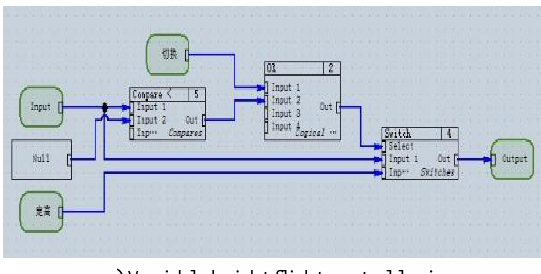
Figure 4. Control logic of autonomous variable height flight